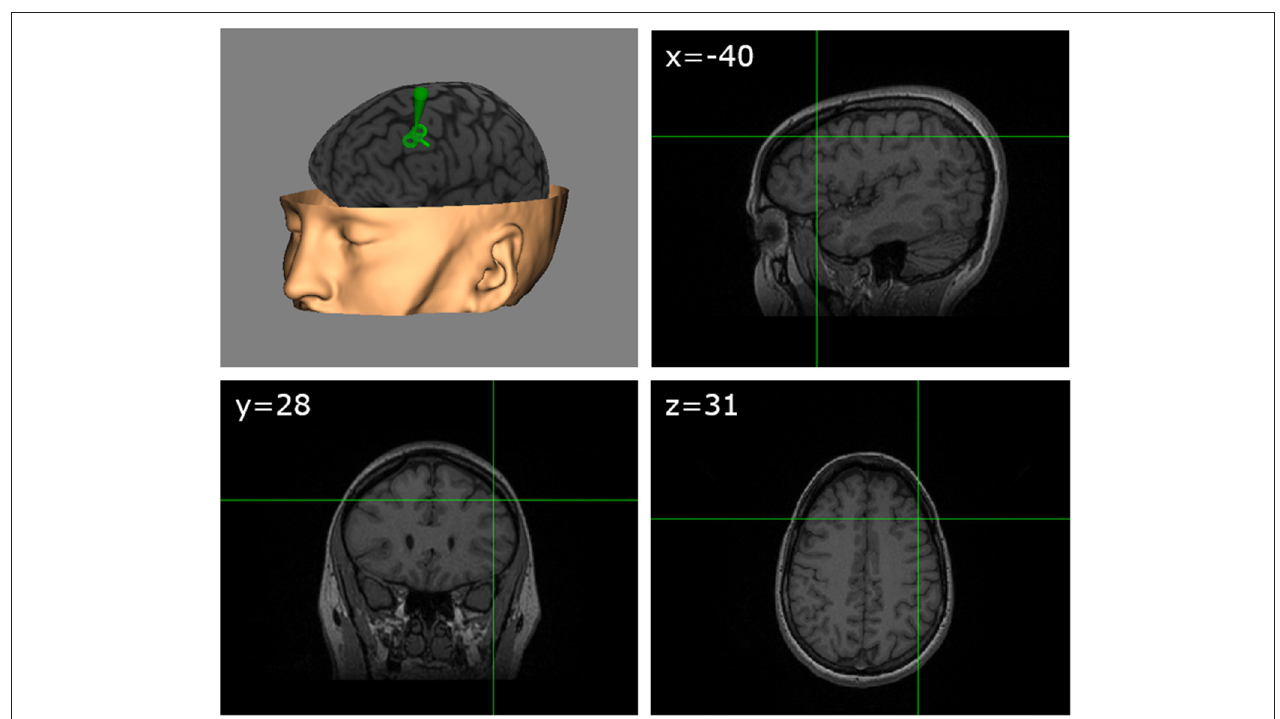
FIGURE 2 | TMS target. Schematic figure showing on an MRI 3D reconstruction from a representative participant (with permission) the TMS targeted left dlPFC region identified according to standardized MNI coordinates (x = − 40, y = 28, z = 31).